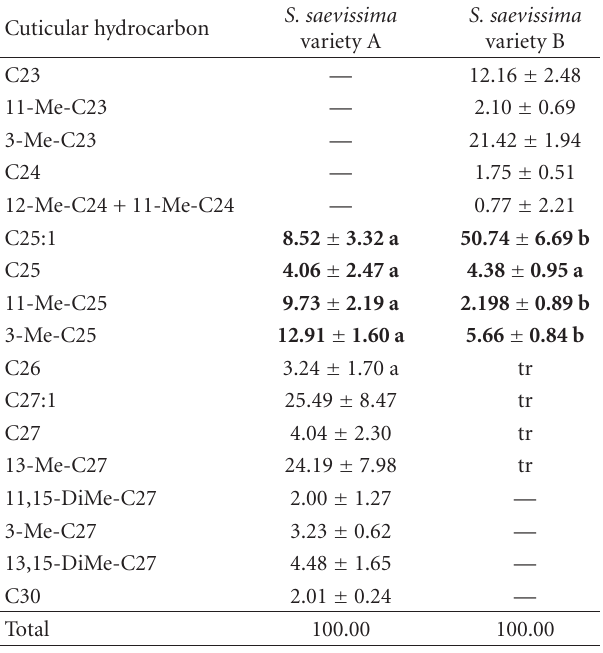
Table 3: Relative abundance (%) of cuticle hydrocarbons from random worker samples of Solenopsis saevissima varieties A ( n = 5) and B ( n = 13) obtained from di ff erent nests from three di ff erent states in Brazil (see Figure 1). Values given in bold were tested for each species variety using Students’ t - test, and di ff ering means were attributed to di ff erent